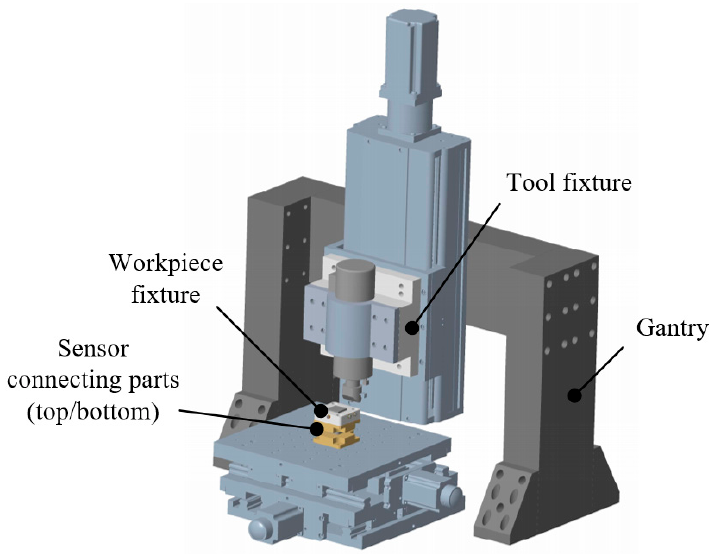
Figure 4. Mechanical structures of the proposed UIP-based device.